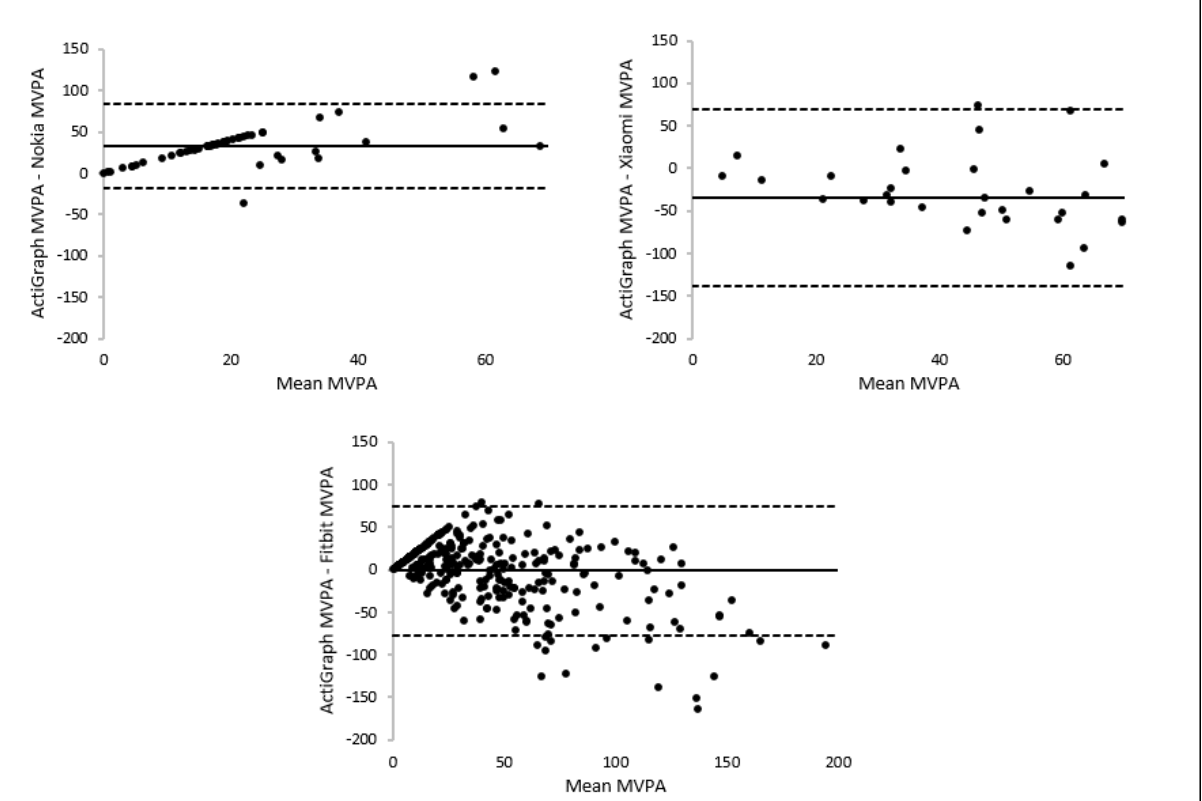
Figure 6. Bland-Altman plots of the trackers for measuring moderate-to-vigorous physical activity. The middle line shows the mean difference (positive values indicate an underestimation of the wearable, and negative values indicate an overestimation) between the measurements of moderate-to-vigorous physical activity of the wearables and the ActiGraph, and the dashed lines indicate the limits of agreement (1.96×SD of the difference scores).